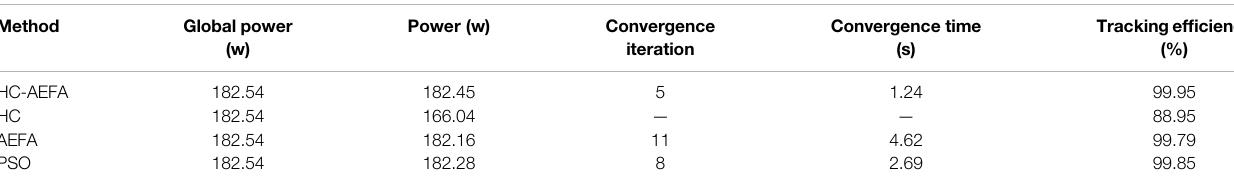
voltage, current, and the converter duty-cycle curves. The results indicated that the HC-AEFA method reached the global peak value with fewer oscillations and higher